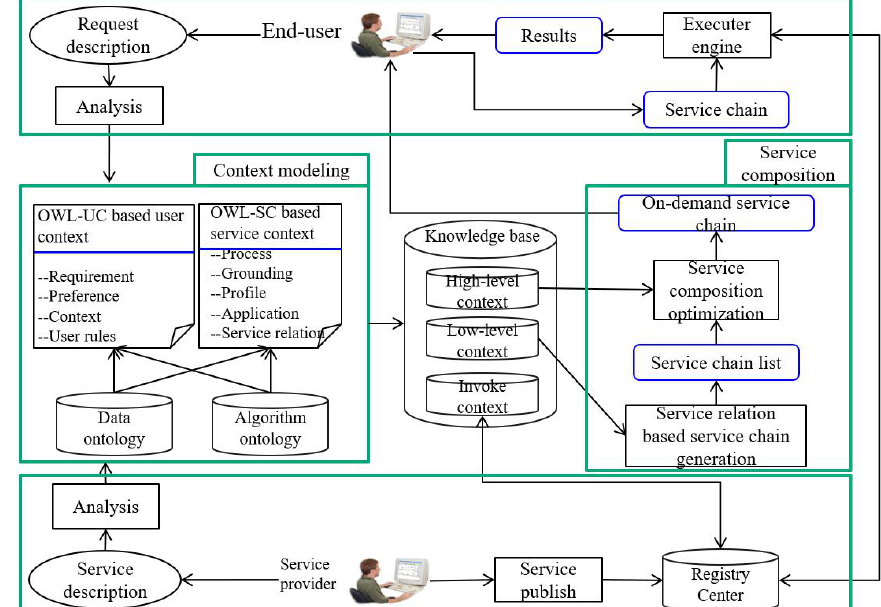
Fig.3 On-demand service model based on semantic